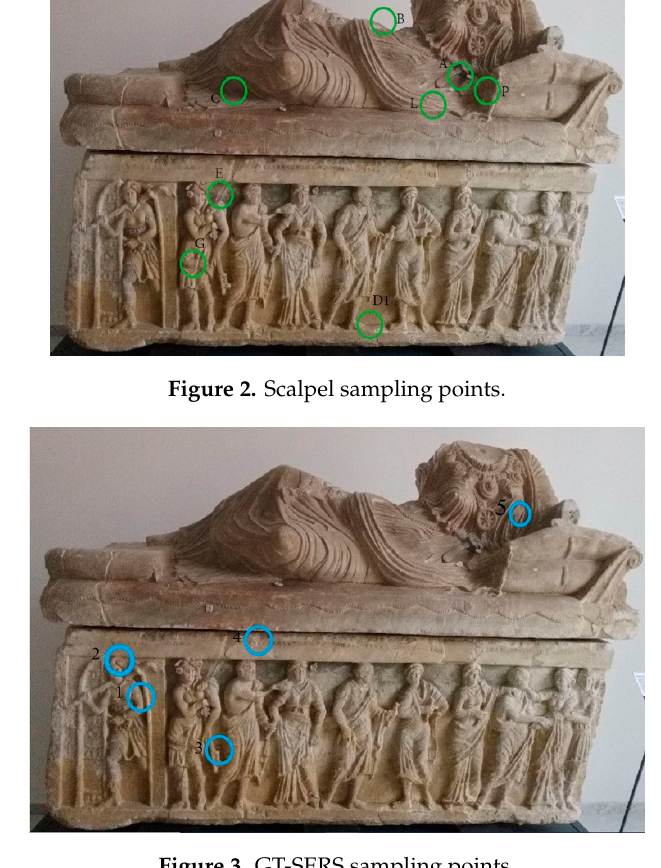
Figure 3. GT-SERS sampling points.